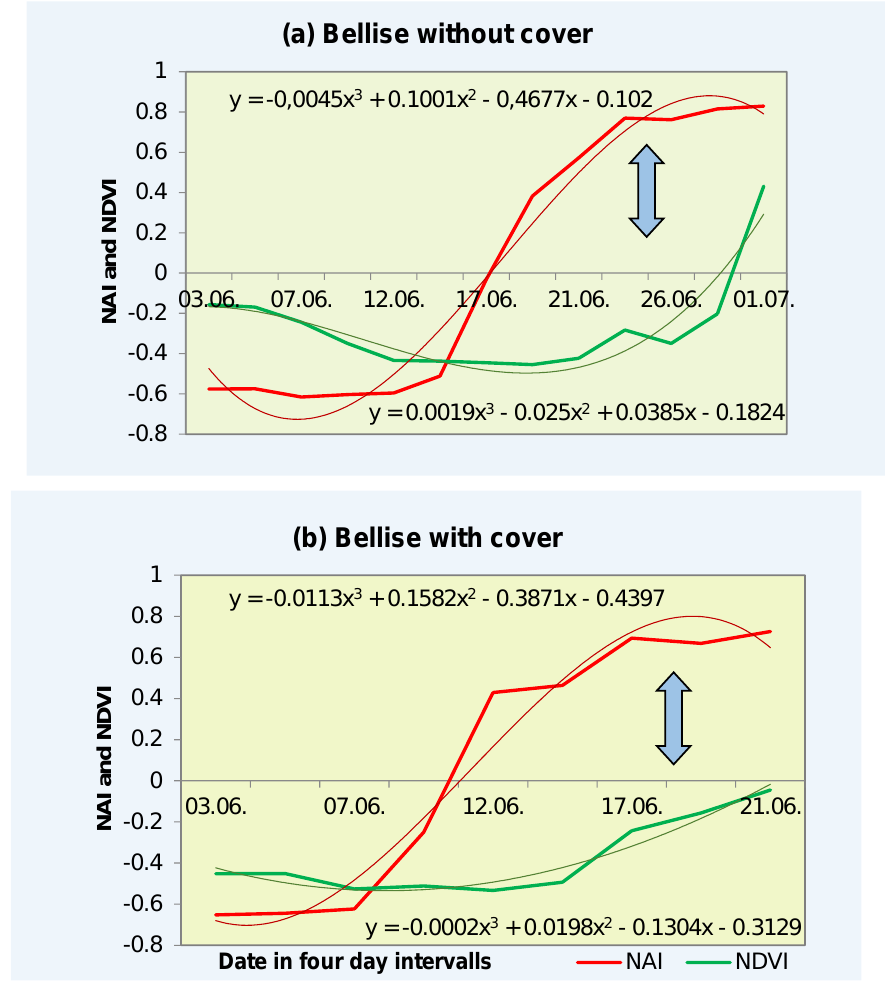
Figure 4. NAI and NDVI levels in 2013 of cv. “Bellise” without ( a ) and with cover ( b ); n = 20, polynomial function evaluate with median of the measurements; arrows show the optimum harvest date (OHD).